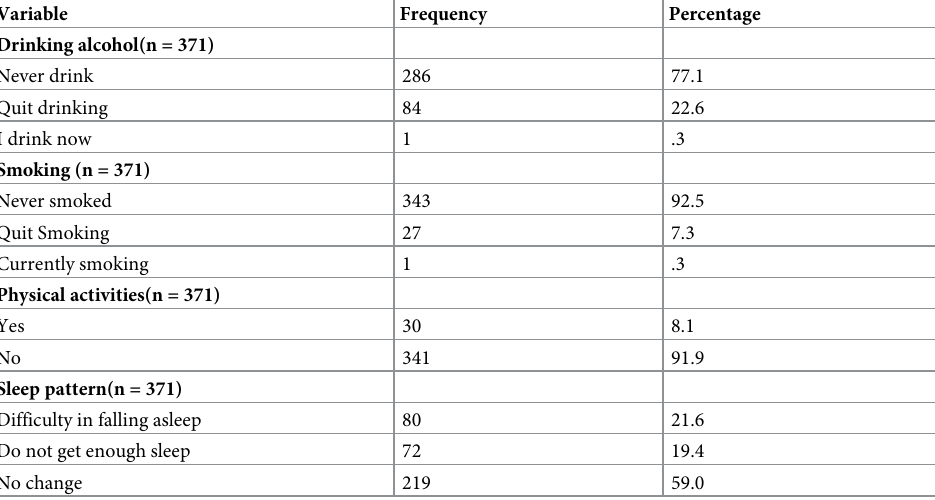
Table 2. Life style patterns of CKD patients in Saint Paulo’s and Zewditu Memorial Hospitals in Addis Ababa, Ethiopia,